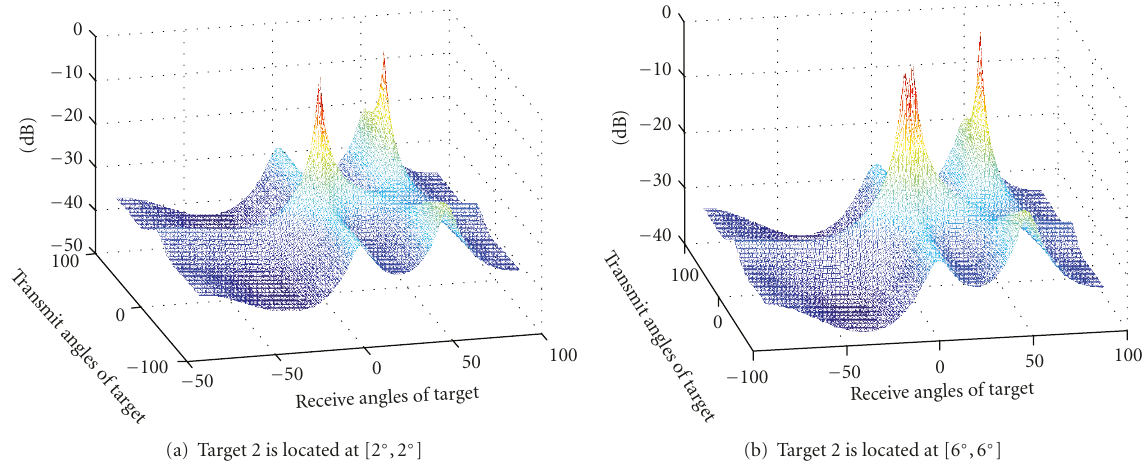
Figure 10: Identifiability of the adjacent targets (Target 1 [0 ◦ ,0 ◦ ]; Target 3 [50 ◦ ,50 ◦ ]; SNR = 8dB, σ 2